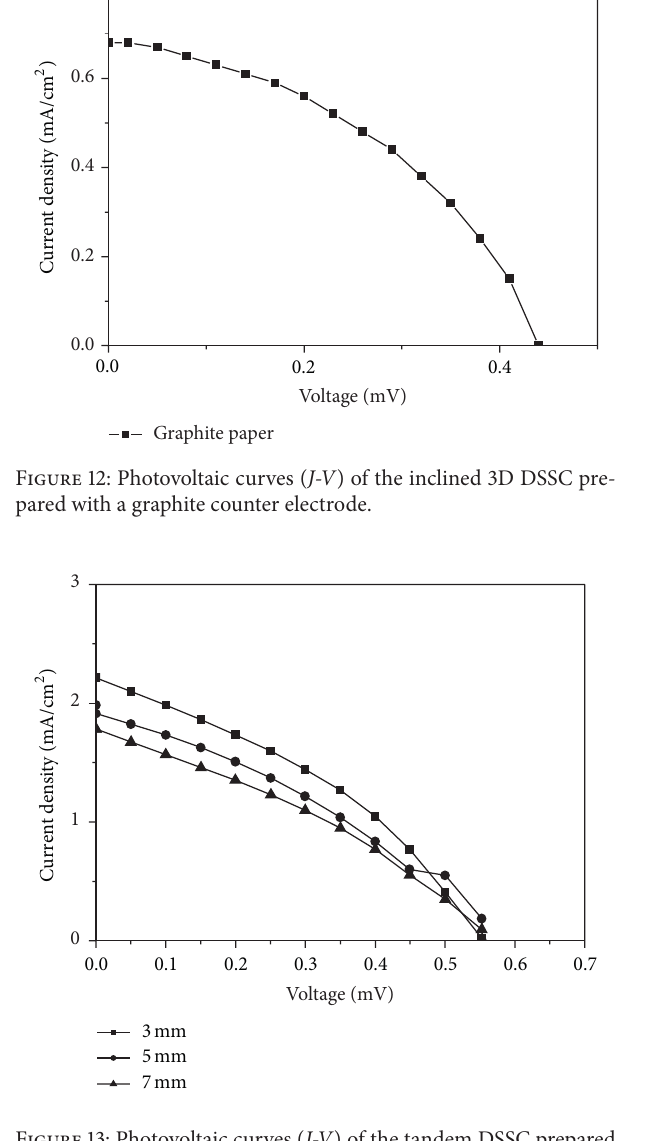
Figure 13: Photovoltaic curves ( J-V ) of the tandem DSSC prepared with a graphite counter electrode.